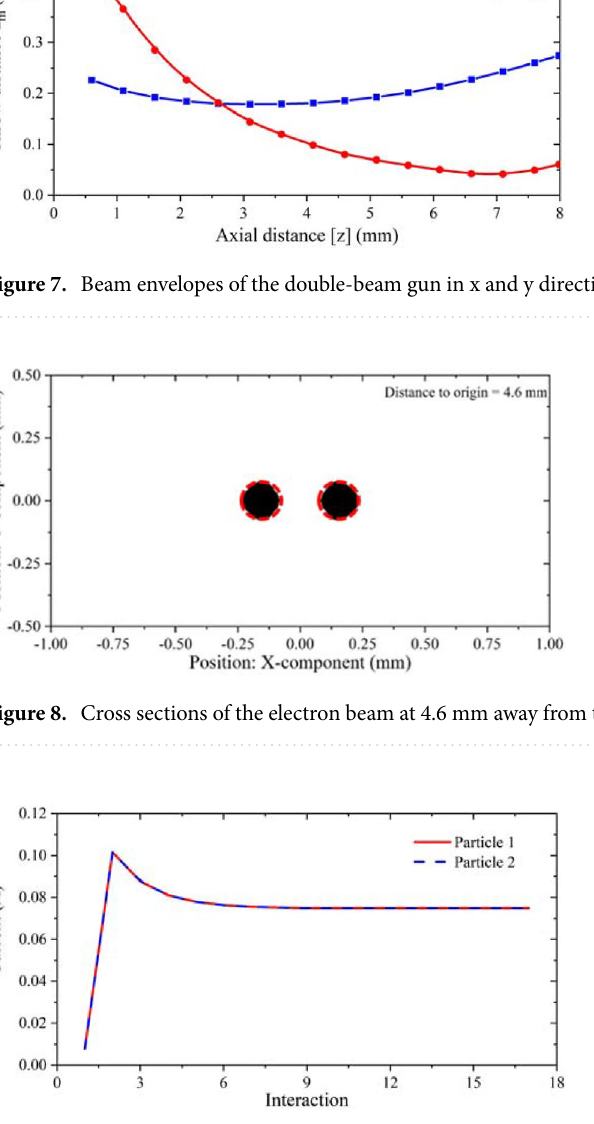
Figure 9. Simulation results of current generated by double-beam electron